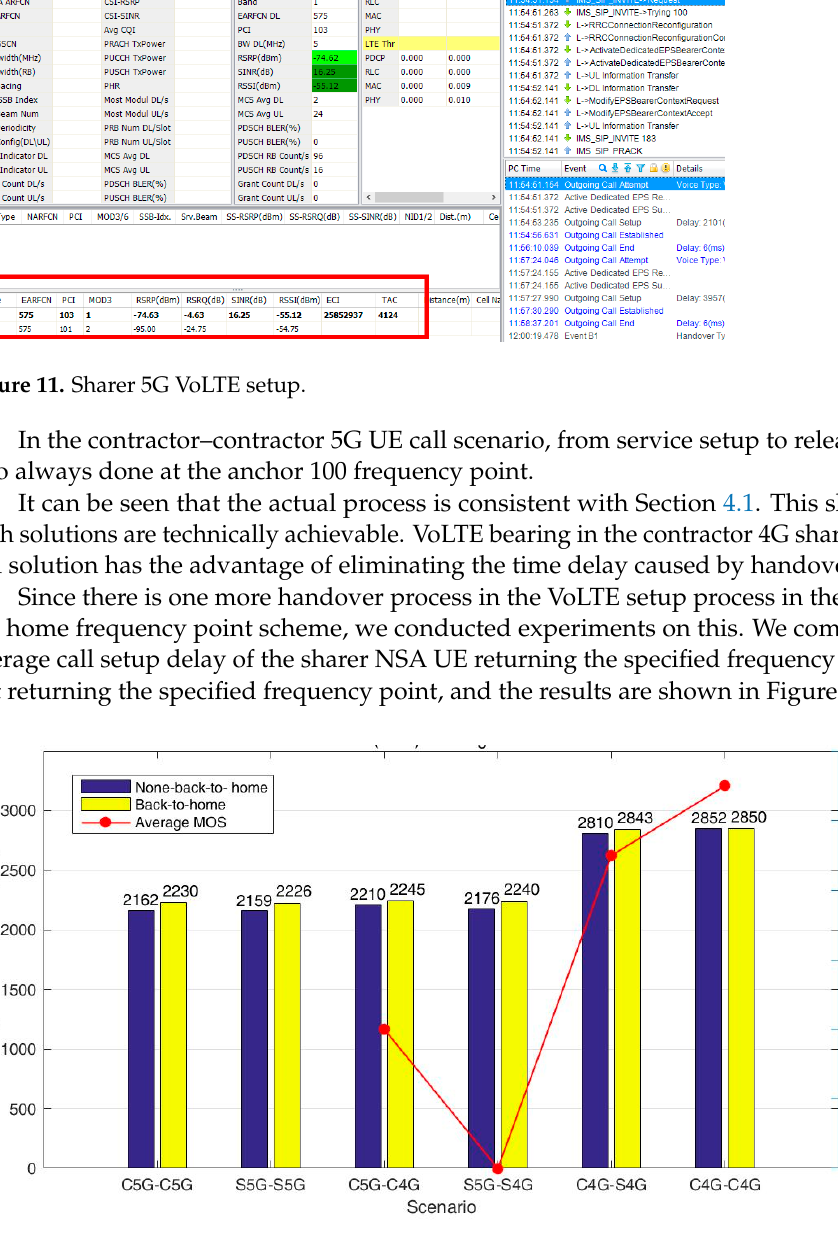
Figure 10. Sharer VoLTE setup.